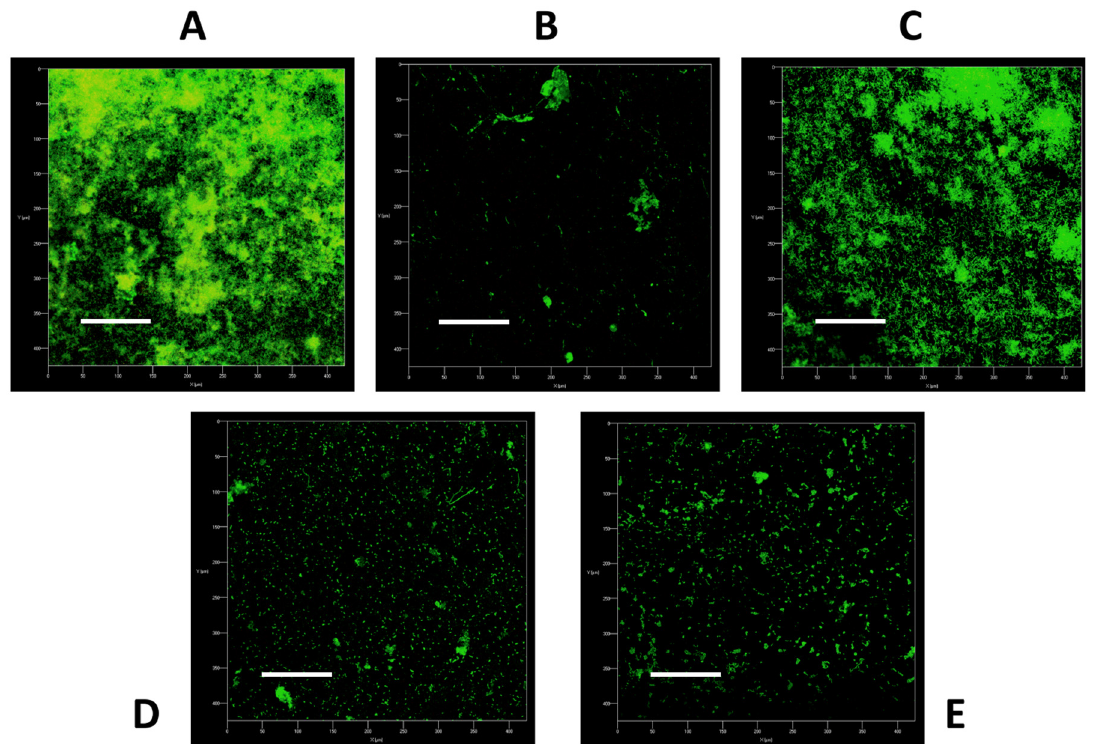
Figure 2. Confocal images of the non-treated and treated biofilms. Treatment regimens: ( A ), non- treated; ( B ), brushing with denture cleanser; ( C ), brushing only; ( D ), brushing with Colgate ® ; ( E ), brushing with Crest ® . Overlaid images were representative of compiled z-stacks (a series of confocal images taken at different focal depths across the same x- and y-axes) taken from one experiment on the Zeiss LSM780 confocal laser scanning electron microscope. Scale bars represent 100 µ